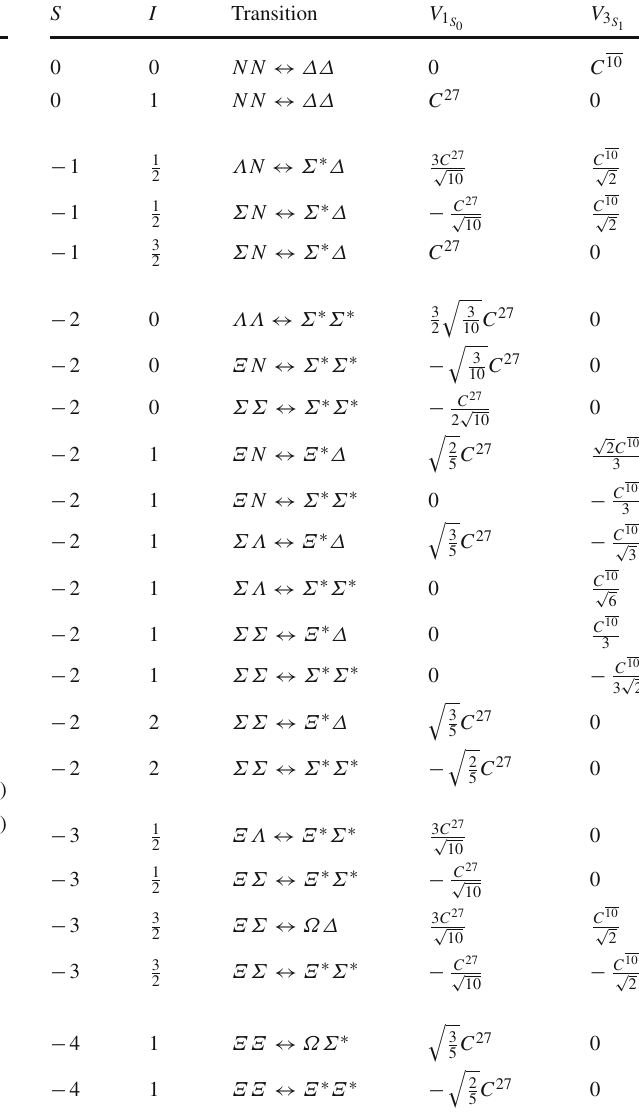
Table 8 SU(3) relations of BB → DD (and DD → BB) in non- vanishing partial waves. The subscript { 02 } of the constants C r that 01 denotes the BB channel is omitted in the